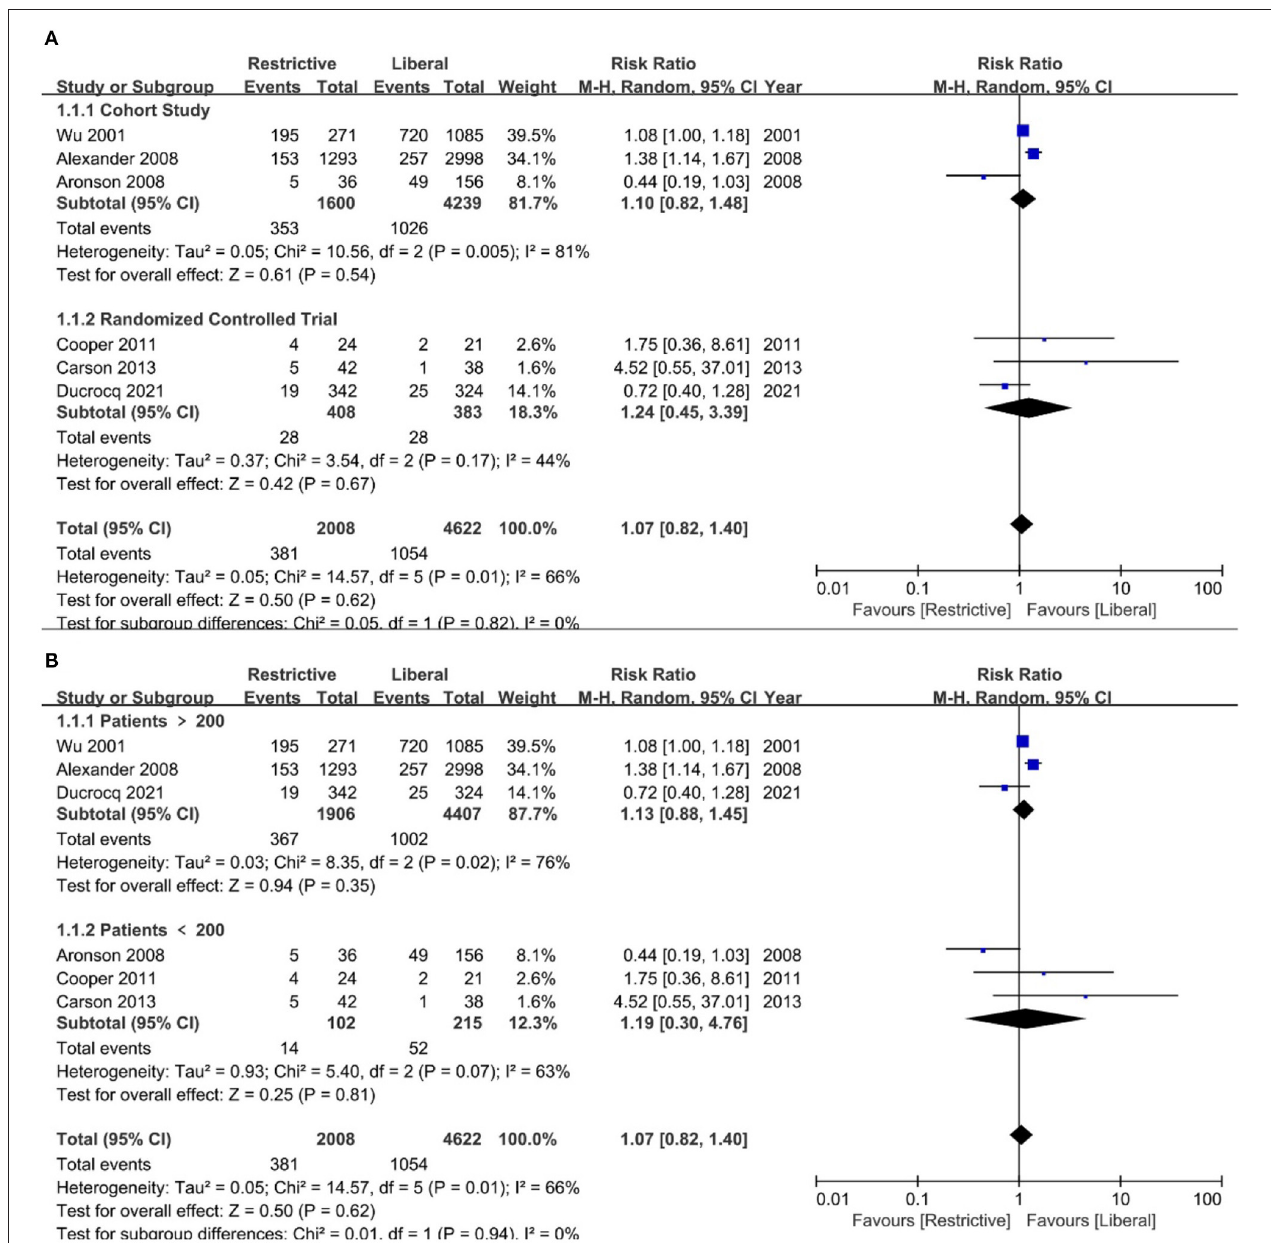
FIGURE 4 | Subgroup analysis of overall mortality for blood transfusion strategies according to study design and sample size. (A) : Study design; (B) : study sample